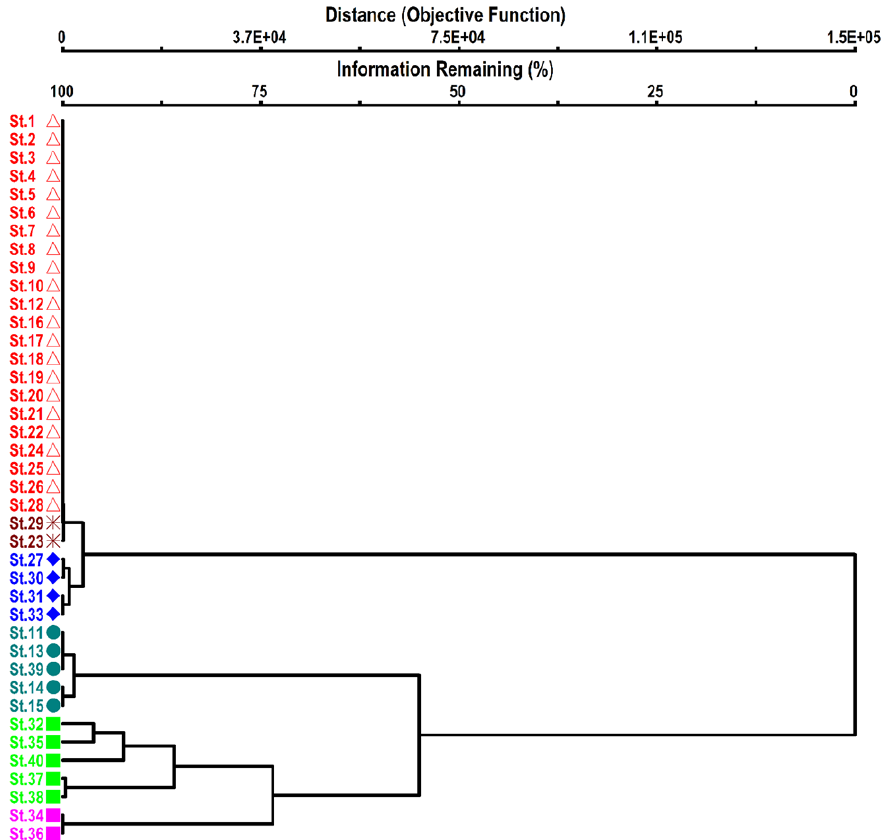
Figure 2. Dendrogram derived from Ward’s cluster analysis using the importance value of tree species from the Shangla district. The different colors indicate different floristic composition with respect to their environmental variables. (St indicates different stands in groups of vegetation.)